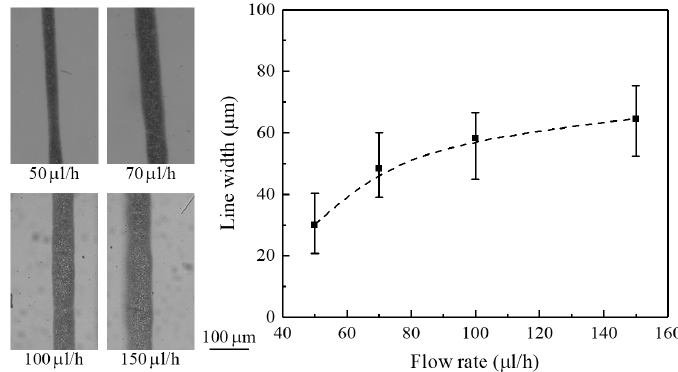
Figure 8. The effect of flow rate on line width. The applied voltage is 1.5 kV, and the nozzle-to-substrate distance is 0.5 mm.